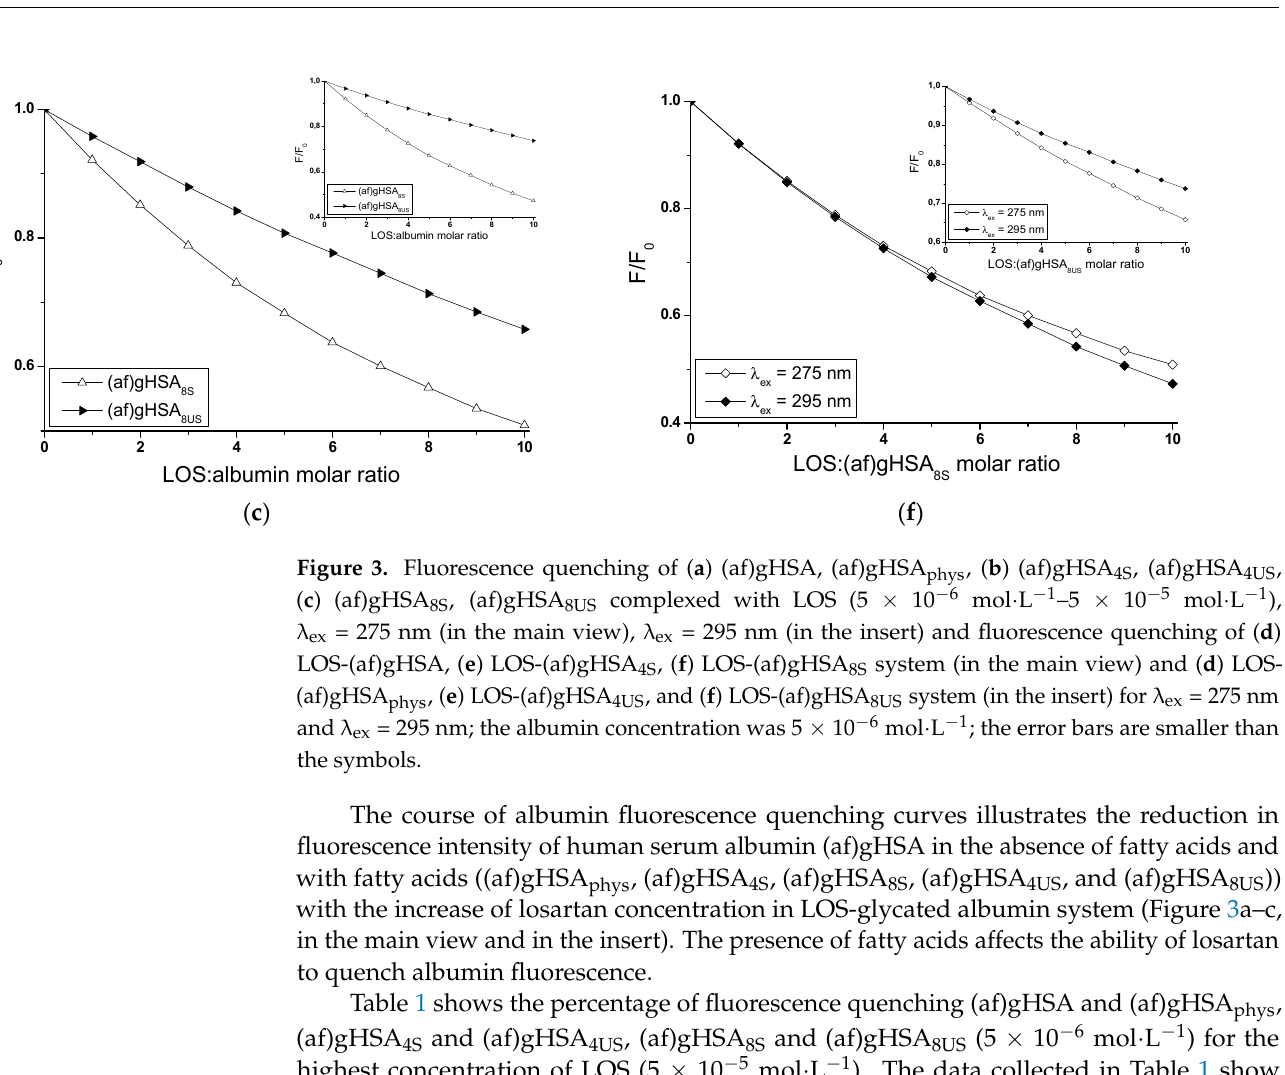
Table 1. Fluorescence quenching of LOS-(af)gHSA, LOS-(af)gHSA phys , LOS-(af)gHSA 4S , LOS- (af)gHSA 4US , LOS-(af)gHSA 8S , an LOS-(af)gHSA 8US systems and the fluorescence quenching per- centage at λ ex = 275 nm and λ ex = 295 nm excitation wavelength; albumin and losartan concentrations